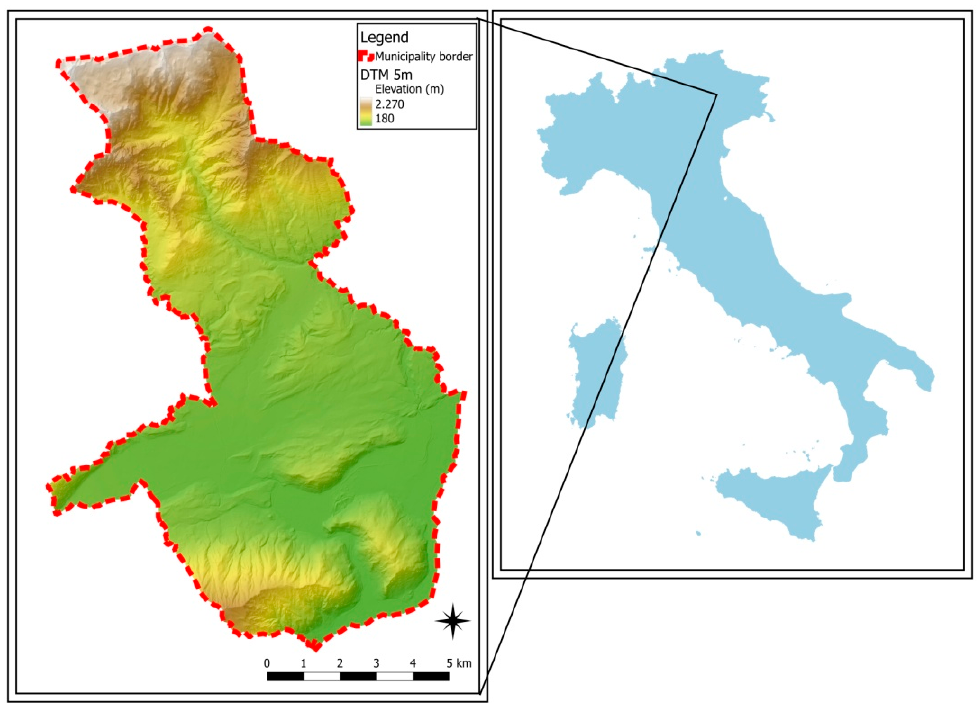
Figure 1. Geographic map of the municipality of Feltre.